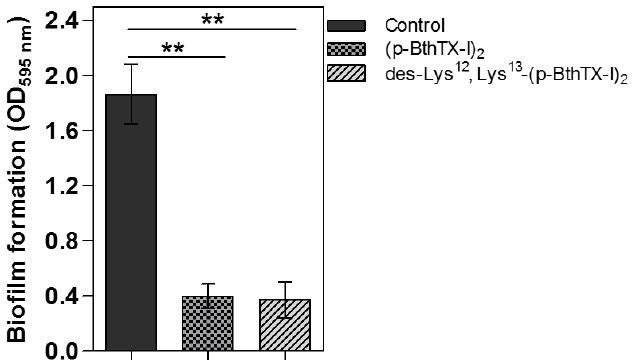
Figure 4. Biofilm eradication activities of (p-BthTX-I) 2 and des-Lys 12 /Lys 13 -(p-BthTX-I) 2 . S. epidermidis ATCC 35984 growth observed after treatment with the peptides at 512 µM (** p < 0.01). The columns represent mean ± standard deviation (SD) of 16 replicates for each treatment.